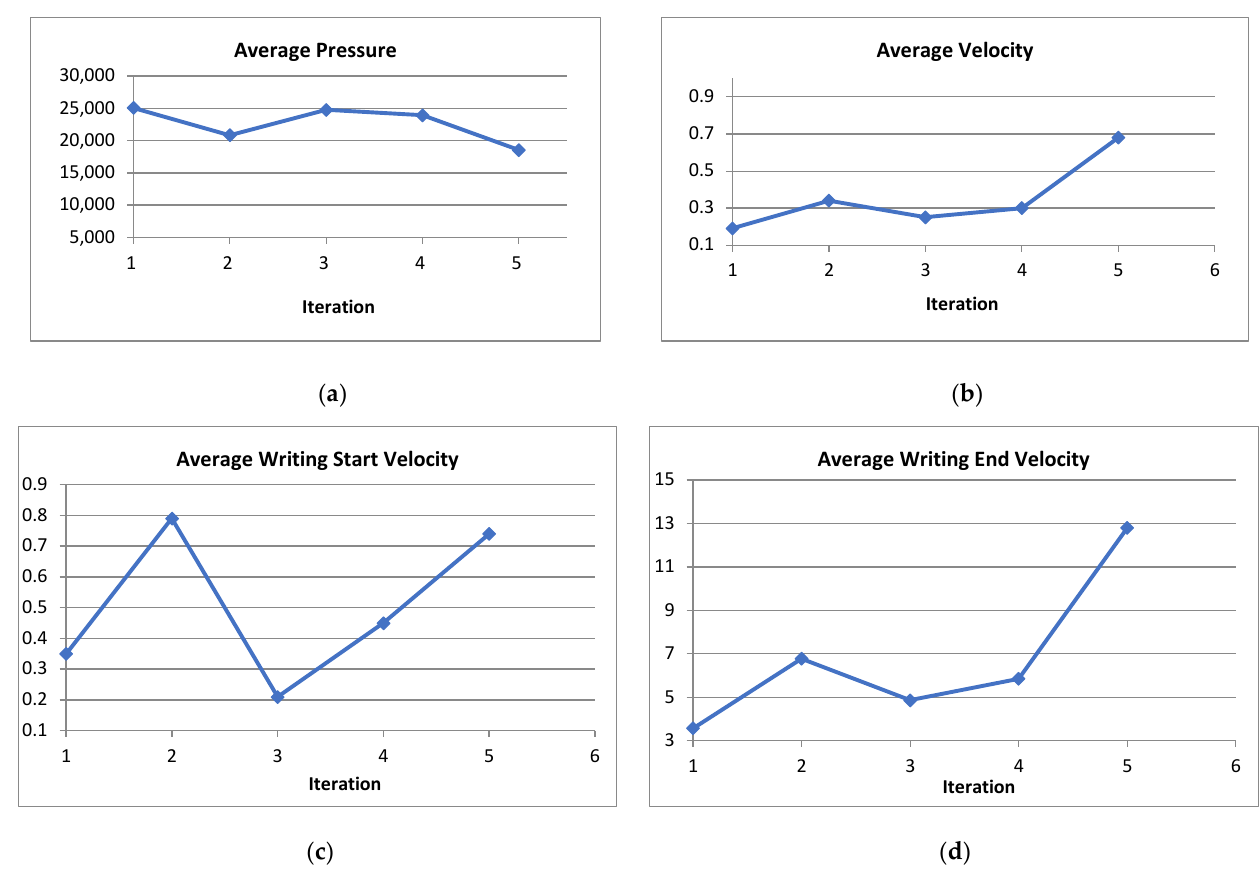
Figure 9. Sample Handwriting Features for Different Persons: ( a ) average pressure ( b ) average velocity ( c ) average writing